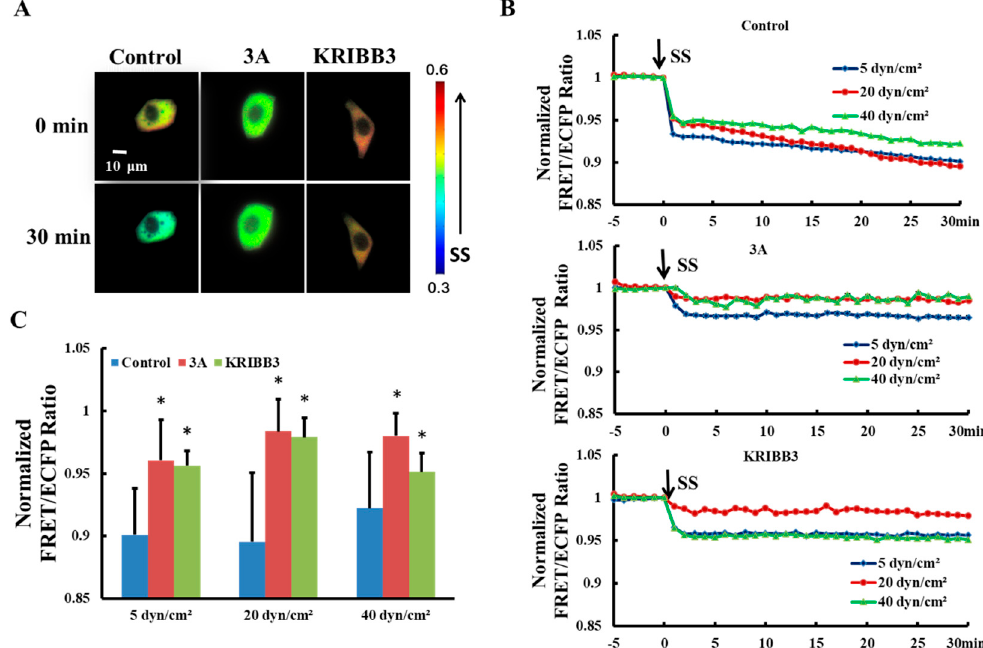
Figure 2. Effect of HSP27 phosphorylation on shear-stress-induced HSP27 depolymerization. ( A ) FRET ratio images of the control, 3A, and KRIBB3 groups before and after 20 dyn/cm 2 of shear stress stimulation. ( B ) The fluorescence resonance energy transfer (FRET) ratio in the control, 3A, and KRIBB3 groups under different magnitude of shear stress (SS, from 0 min) after normalization. ( C ) The FRET ratio comparison in the control, 3A, and KRIBB3 groups (* p < 0.05 when comparing to the control group, with values taken from the 30 min time point). n for 5, 20, and 40 dyn/cm 2 in the control group is 24, 12, and 15; for the 3A group it is 19, 15 and 13; and in the KRIBB3 group it is 17, 20, and 21, respectively.